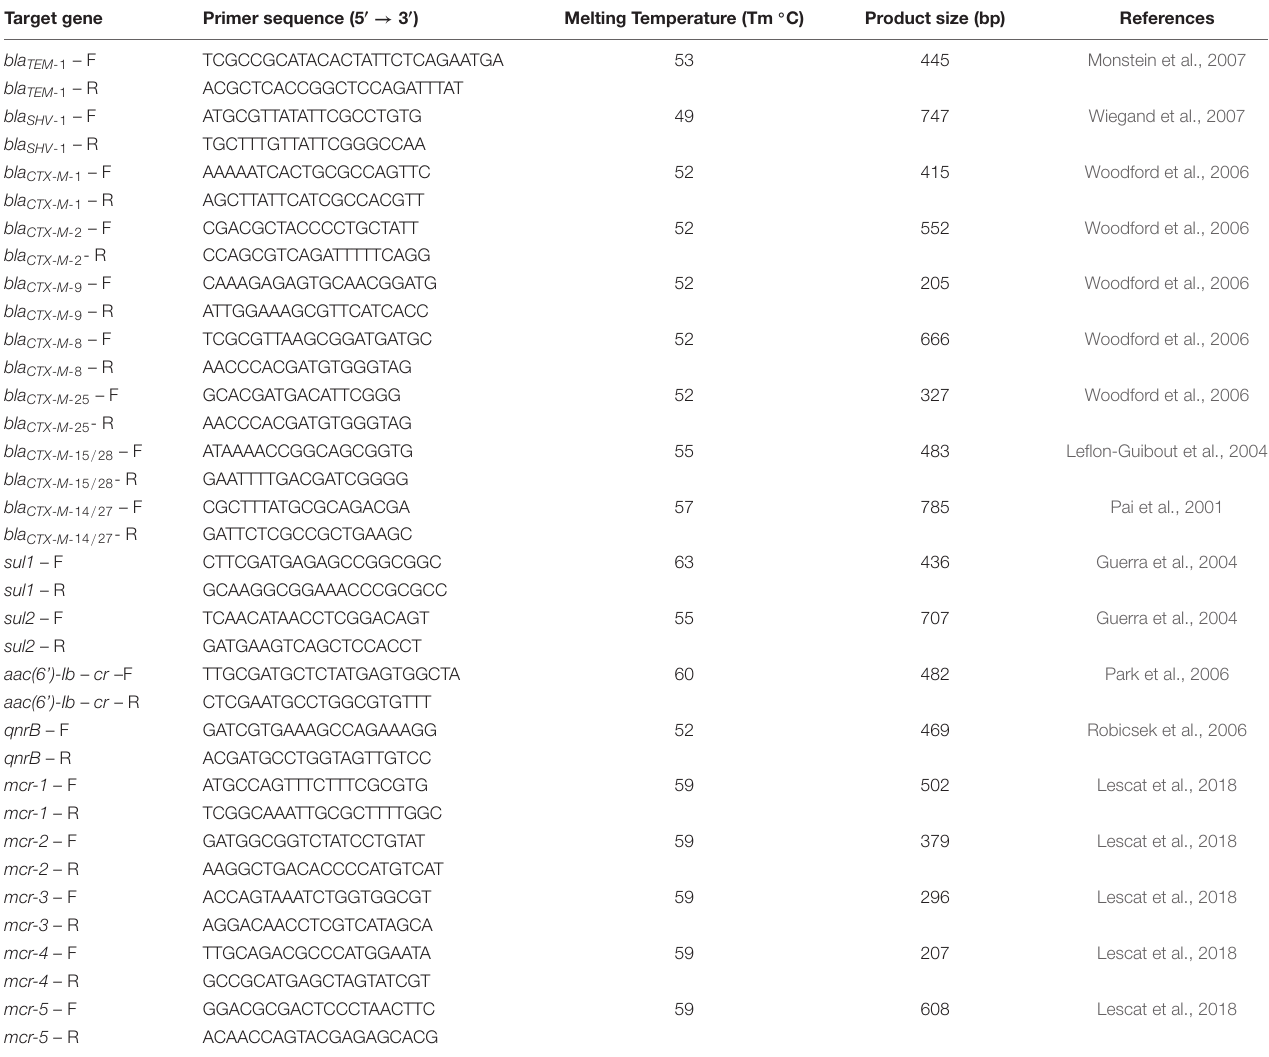
TABLE 1 | Primers to detect antimicrobial resistance genes. Target gene Primer sequence (5 (cid:48) → 3 (cid:48) ) Melting Temperature (Tm ◦